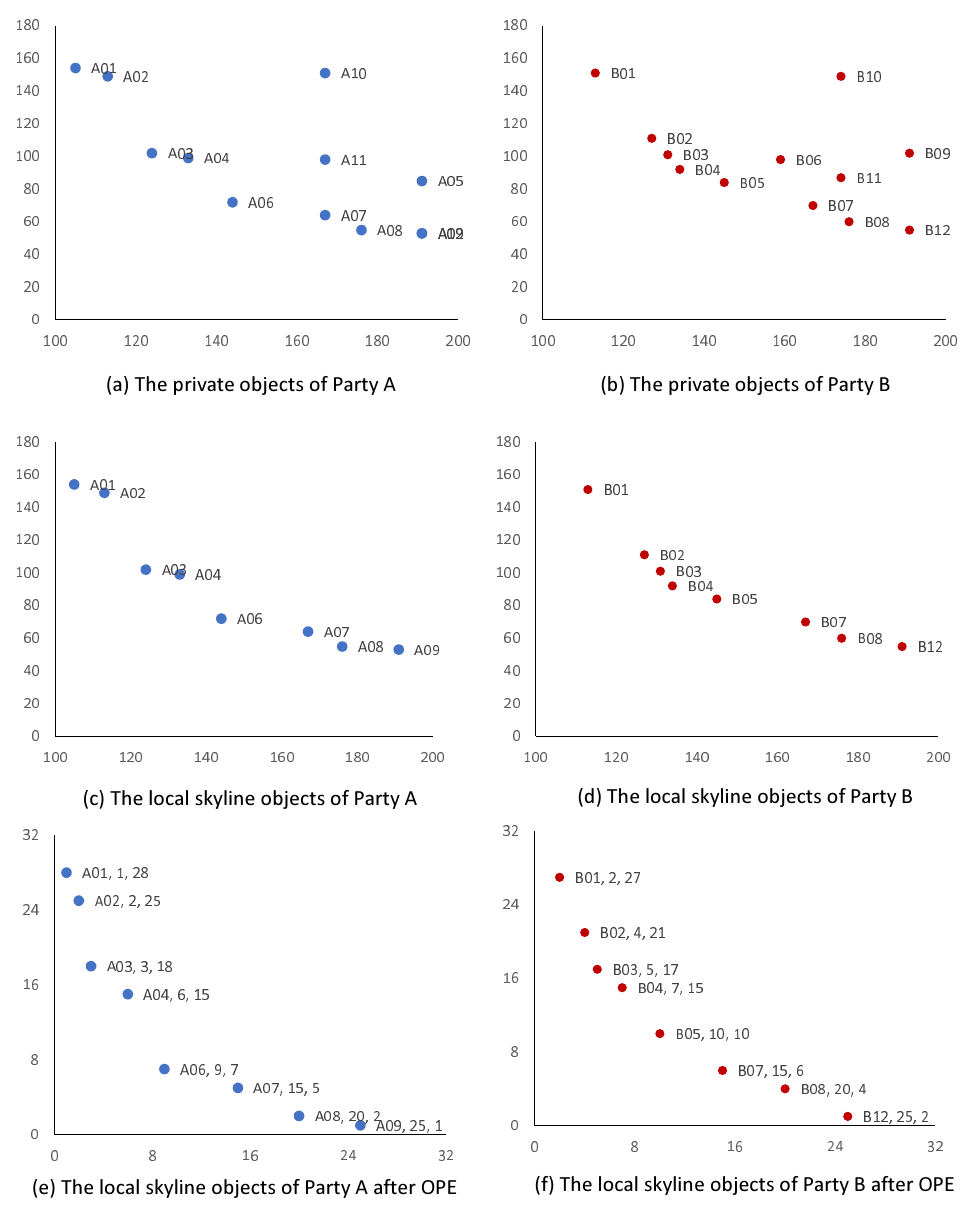
Figure 3. Local skyline of Party A and Party B from their private objects. OPE, Order-preserving